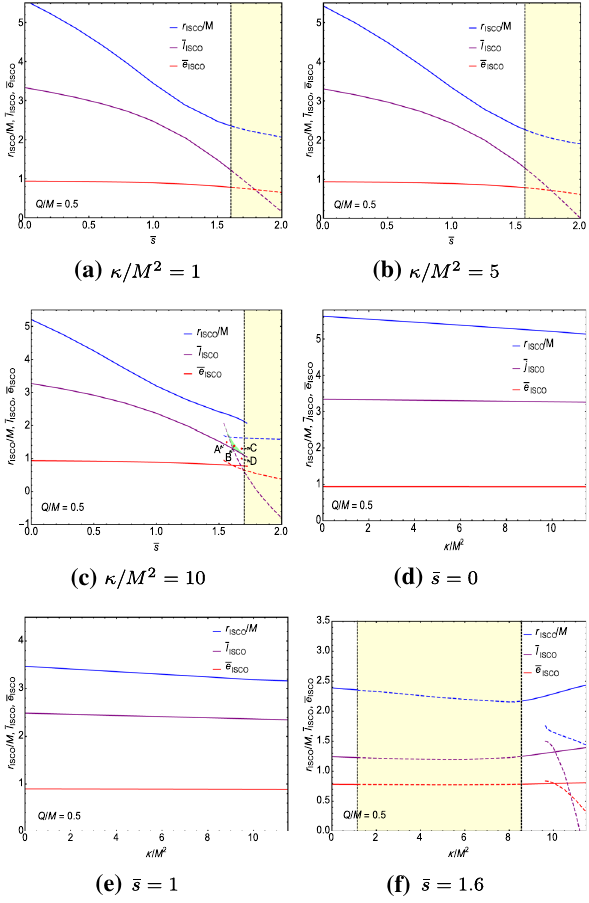
Fig. 7 The radius r ISCO , orbital angular momentum ¯ l ISCO and energy κ and ¯ s , where the thicklines ¯ e ISCO of the ISCO for different parameters refers to the timelike ISCO and dashed to spacelike. The areas colored in light yellow represents the region without timelike